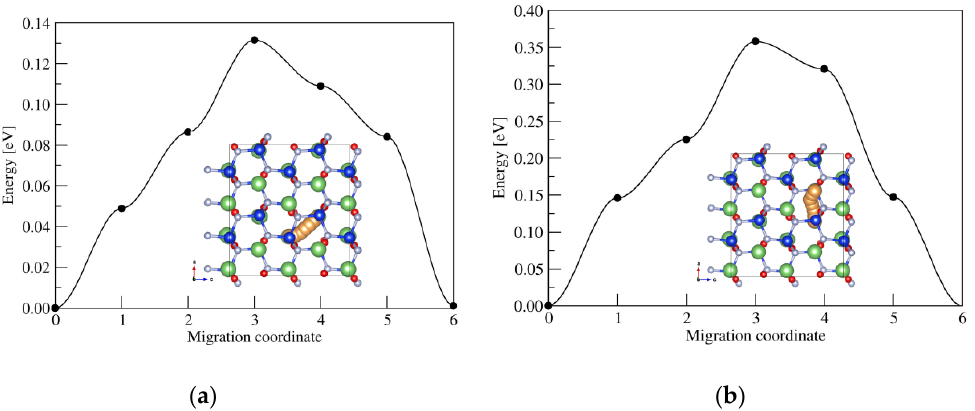
Figure 3. The Li + diffusion energy barriers of ( a ) the inline migration mode, and ( b ) the interline migration model simulated by the NEB method.